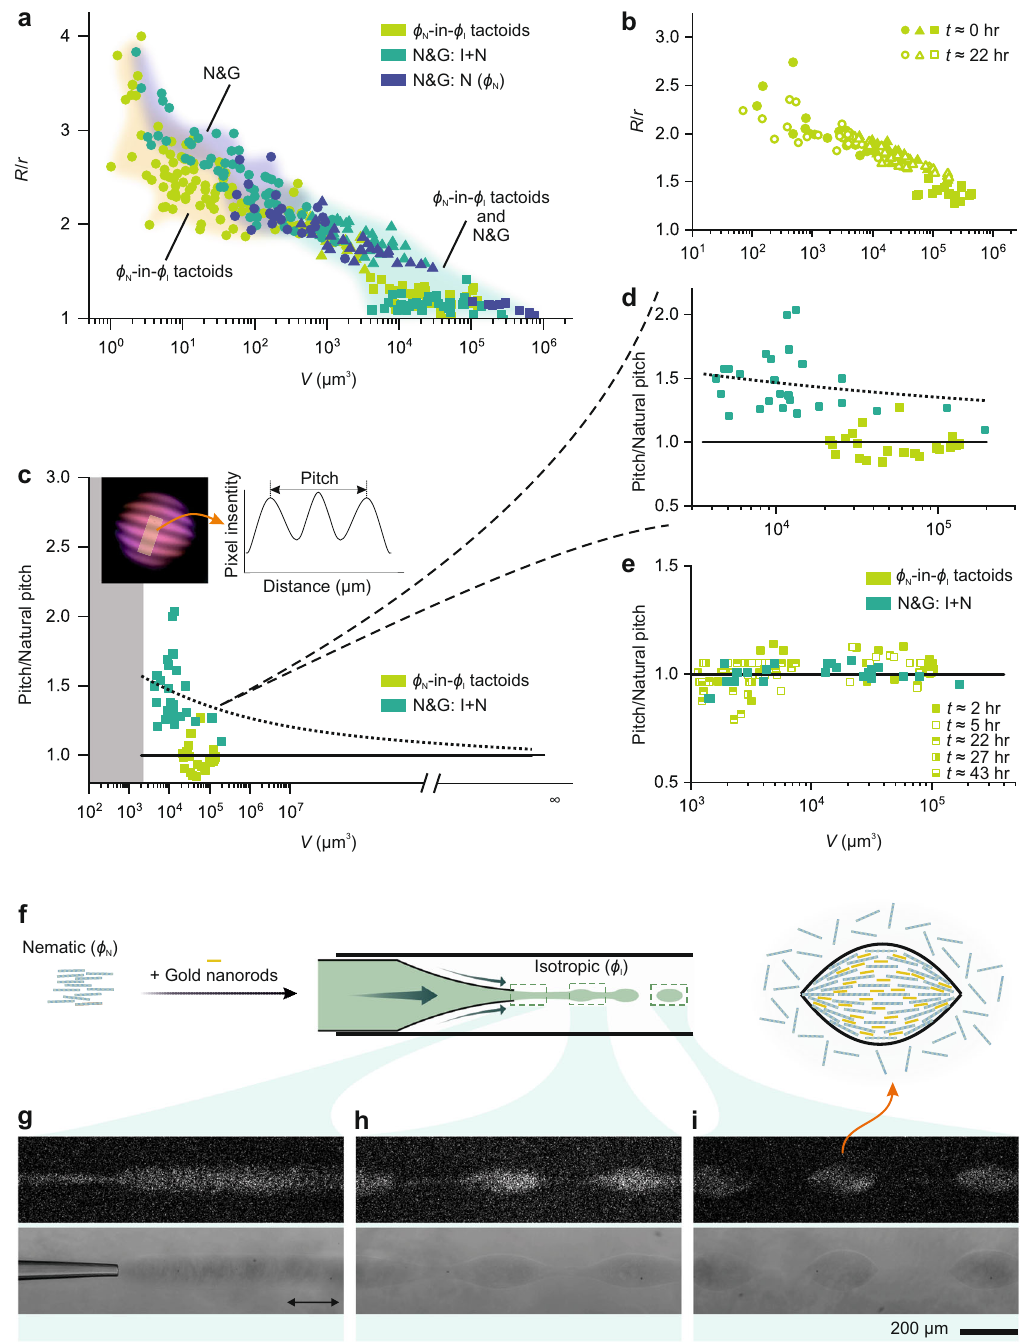
Fig. 4 | Disentangling kinetics from thermodynamics effects reveals unprece- dented physical phenomena. The circle, triangle, and square symbols in plots represent data points from homogenous, bipolar, and cholesteric tactoids, respectively.Filledsymbolsdenotethetactoidscapturedrightaftertherelaxation, while un fi lled symbols represent long-time measurements. a Phase diagram of tactoidsobtainedbyextrudingtheOnsagerbranches( ϕ N -in- ϕ I tactoids)versustwo controlexperimentsfollowingN&G. b Aspectratioversusvolumeofamyloid fi brils tactoids formedby extruding the Onsager branches and trackedover time. c Pitch of cholesteric tactoids of amyloid fi brils obtained via N&G and by extruding the Onsager branches ( ϕ N -in- ϕ I tactoids). While the pitch value decreases with an increase in volume for tactoids formed via N&G, it remains constant for tactoids formedbyextrudingtheOnsagerbranches.Pitchisrenormalizedbytheobservable bulkpitchofthesystemwhichis16.7 µ mforN&Gfromacompositionfallingwithin isotropic+nematic region and 46.1 µ m for tactoids formed by extruding the Onsager branches, calculated as an average value of the pitch of tactoids. (Pitch/